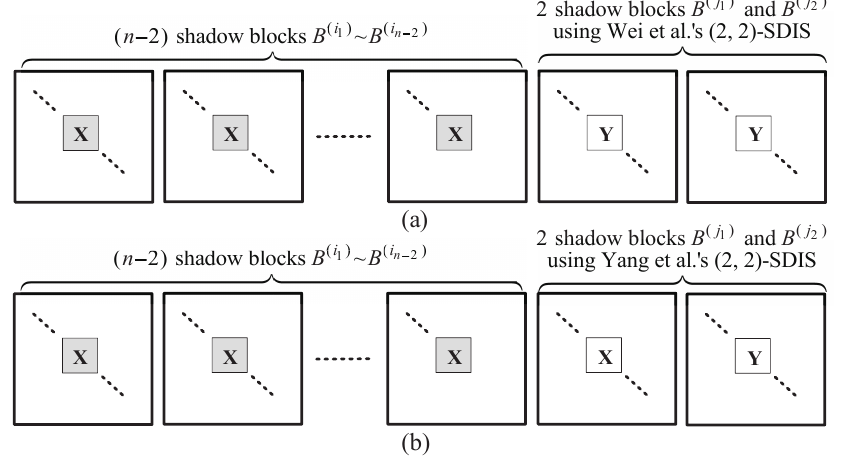
Figure 2. Shadows of the proposed ( n , n ) -SDIS: ( a ) using Wei et al.’s ( 2,2 ) -SDIS for B ( j 1 ) and B ( j 2 ) ( b ) using Yang et al.’s ( 2,2 ) -SDIS for B ( j 1 ) and B ( j 2 )